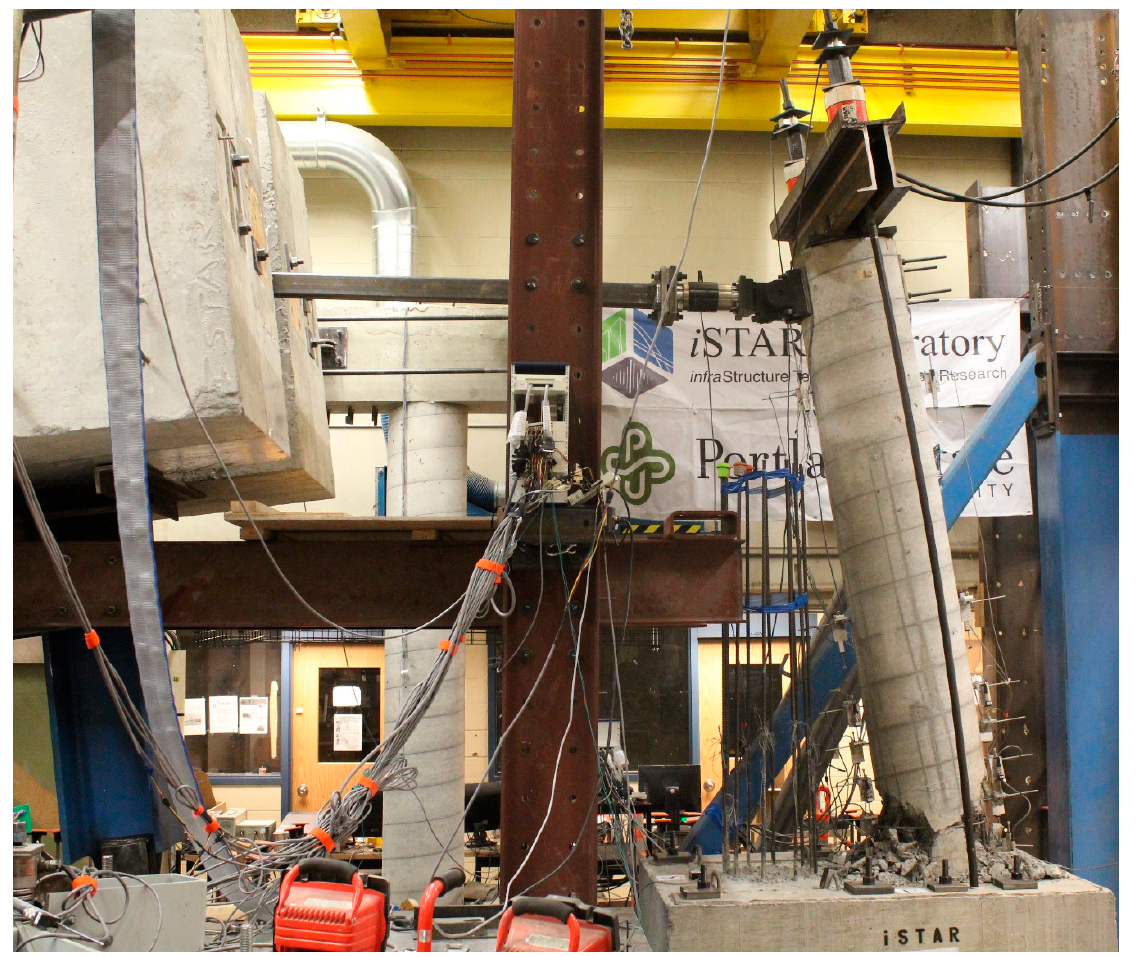
Figure 7. IMS reaching the maximum displacement limit under specimen collapse.